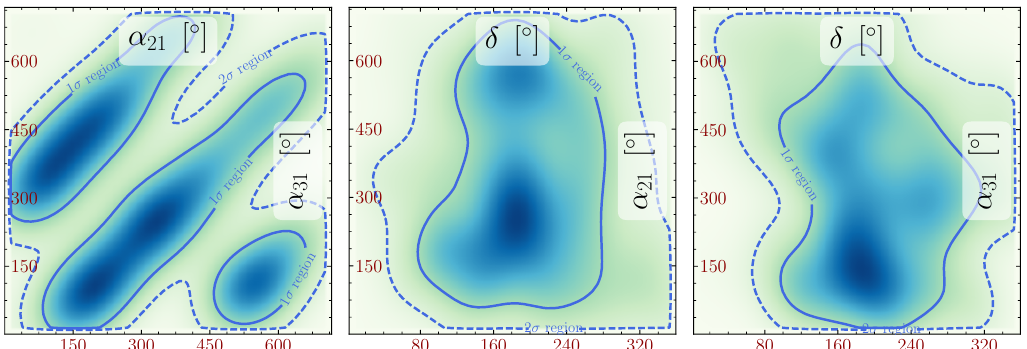
Figure 6 . The two-dimensional projections for leptogenesis with M 1 = 10 11 GeV, M 2 = 10 12 GeV and N 3 decoupled, with CP violation provided only by the phases of the PMNS matrix. Here it is assumed that the light neutrino mass spectrum has normal ordering. Contours correspond to 68% and 95% con(cid:12)dence levels. This plot was created using SuperPlot